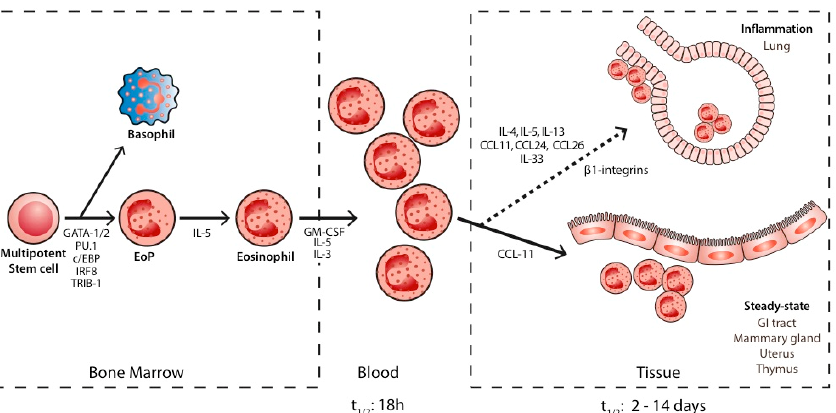
Figure 1. Biology of eosinophils. Eosinophils derive from multipotent stem cells. They proliferate, migrate, and are activated by cytokines, mainly Interleukin-5 (IL-5). They spend a short time in